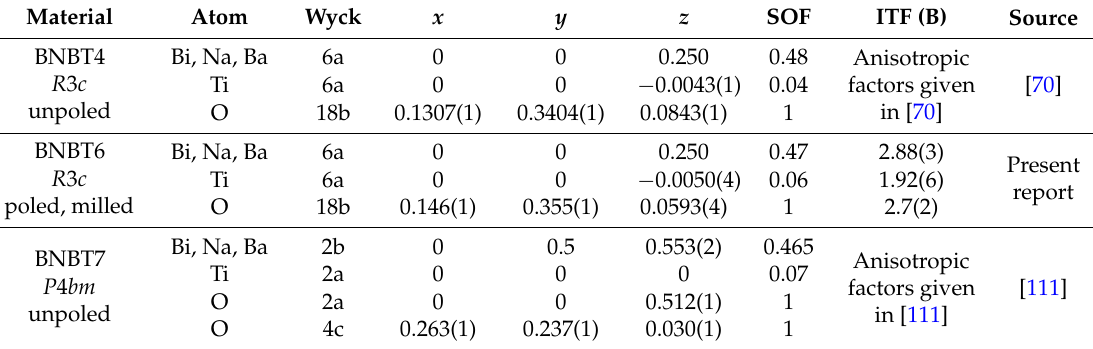
Table 5. BNBT x ( x = 4, 6, 7) atomic coordinates. To facilitate comparison with other reports, all the atomic coordinates have been referred to the most commonly used coordinate